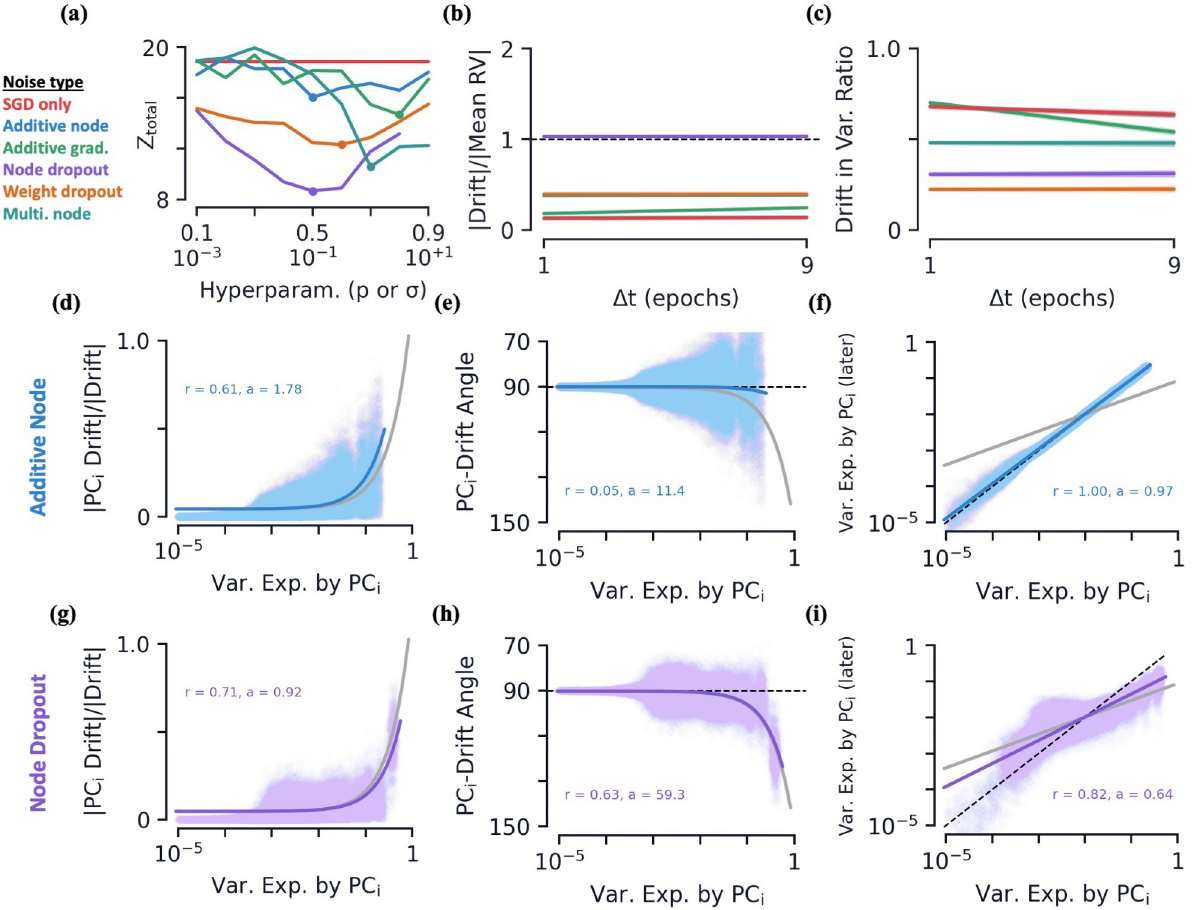
Fig 5. Artificial neural networks: Hyperparameter fits and drift geometry as a function of Δ t and variance explained. (a) Measure of fit to experimental data, Z total see Eq (19), as a function of noise hyperparameters, p (top labels) or σ (bottom labels). Dots are best fits, for which additional data is plotted here and in supplemental figures (S5 Fig, Methods). [b-c] Various metrics as a function of the time between earlier and later session, Δ t . Colored curves are linear regression fits. All data is averaged over 10 initializations. (b) Average magnitude of drift relative to magnitude of mean response vector. (c) Average percent of drift vector that lies in the variational space of initial session. [d-i] Various drift metrics and their dependence on PC dimension of the earlier session’s variational space. Metrics are plotted as a function each PC i ’s ratio of variance explained, v i , of the corresponding stimulus group Colored curves are linear regression fits. Grey curves are behavioral data fits from the novel sessions shown in Fig 4c, 4d and 4e. Middle row is for networks with additive Gaussian noise ( σ = 0.1) and bottom row is with node dropout ( p = 0.5). All data is averaged over 10 initializations. (d, g) Magnitude of drift along PC i direction, relative to full magnitude of drift. (e, h) Angle of drift with respect to PC i direction. (f, i) direction (dotted line is equality). Linear regression fit to log(var. Post-drift variance explained along PC i